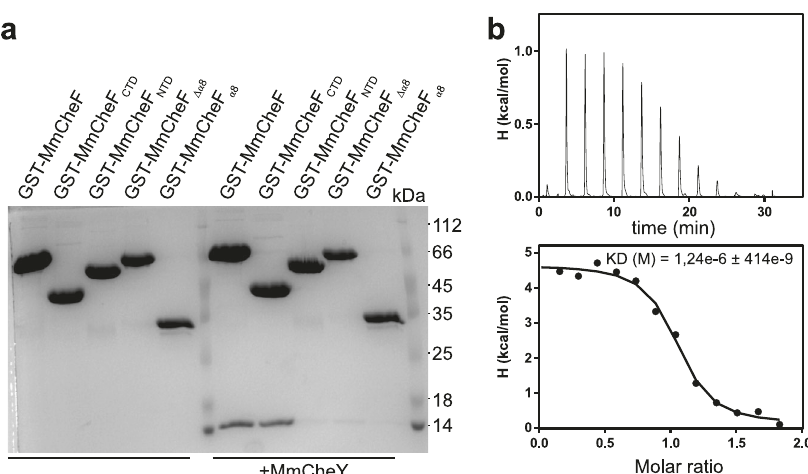
Fig. 2 CheY-P interacts with the CTD of CheF. a Coomassie-stained SDS-PAGE of a GST-interaction assay employing GST-tagged versions of MmCheF and CheY. Representative image derived from three independent experiments. b Isothermal titration calorimetry (ITC) of MmCheY and GST-MmCheF CTD in presence of BeF 3 − yielding a K d of 1.24 ± 0.414 µ M. GST-MmCheF CTD was added to the sample cell and titrated with MmCheY. The black dots represent the Δ H per injection of titrant into the cell and the solid line represents the fi tting curve for all recorded injections. Source data are provided as a Source Data fi